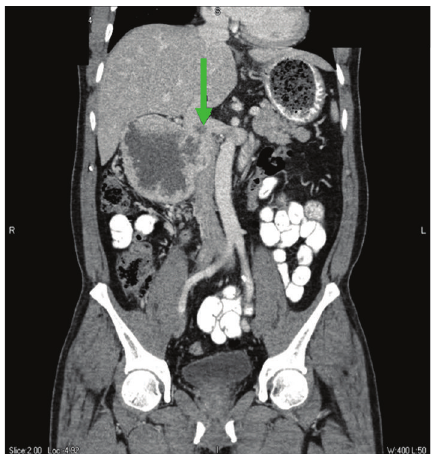
Figure 2: Extension of right kidney mass into the lumen of the inferiorvenacava.Arrowannotatestheinferiorvenacavaandtumor